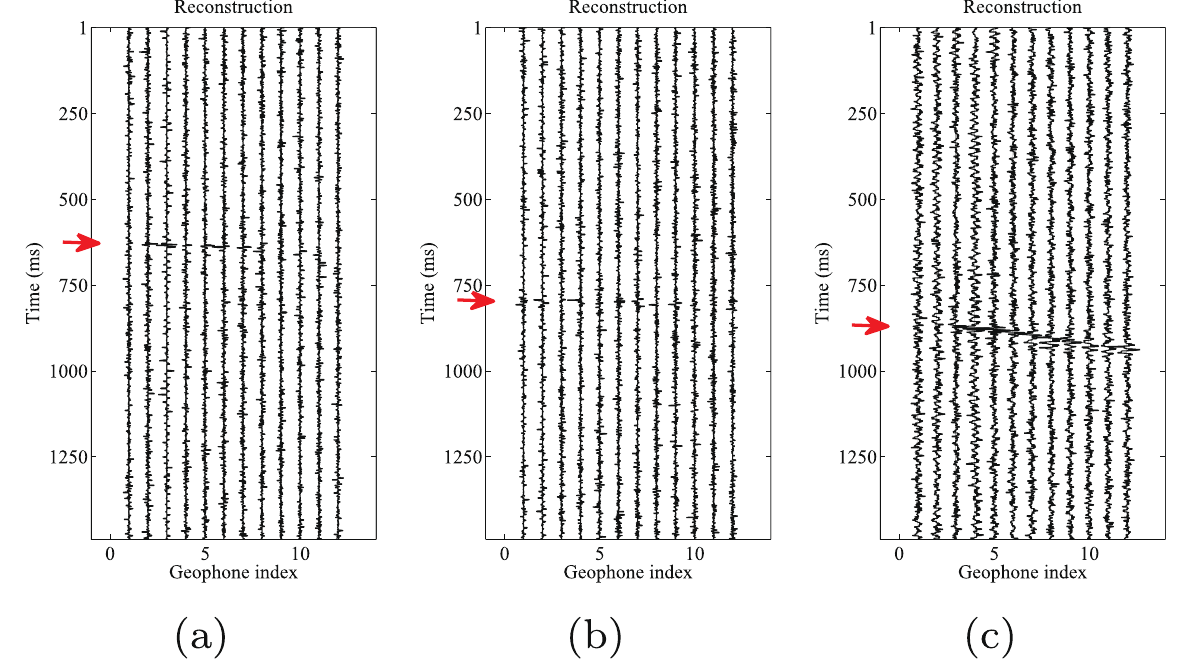
Figure 10. Traditional morphological reconstruction results of ( a ) horizontal components (H1) by 2nd–4th scales components, ( b ) horizontal components (H2) by 2nd–4th scales components, and ( c ) vertical component (V) by 2nd–5th scales components.